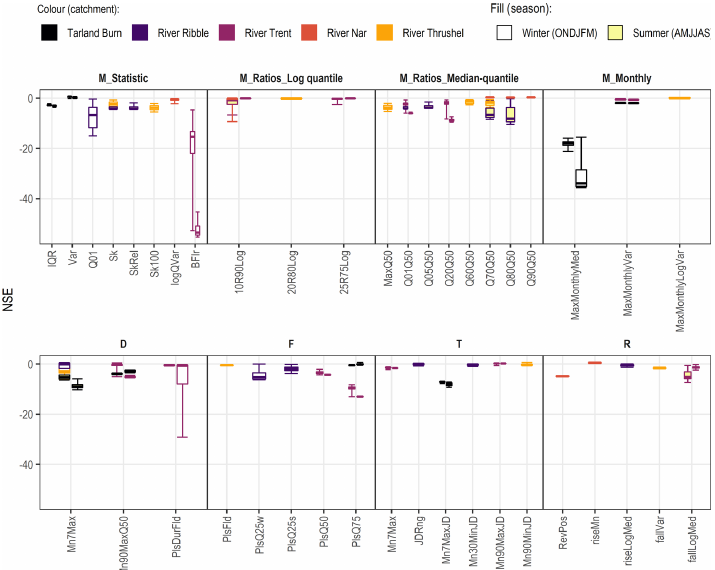
Figure B2. NSE for each ER HI; see Fig. 5 for NSE > 0. The four- and five-parameter results are adjacent, left and right respectively, for the Tarland Burn and River